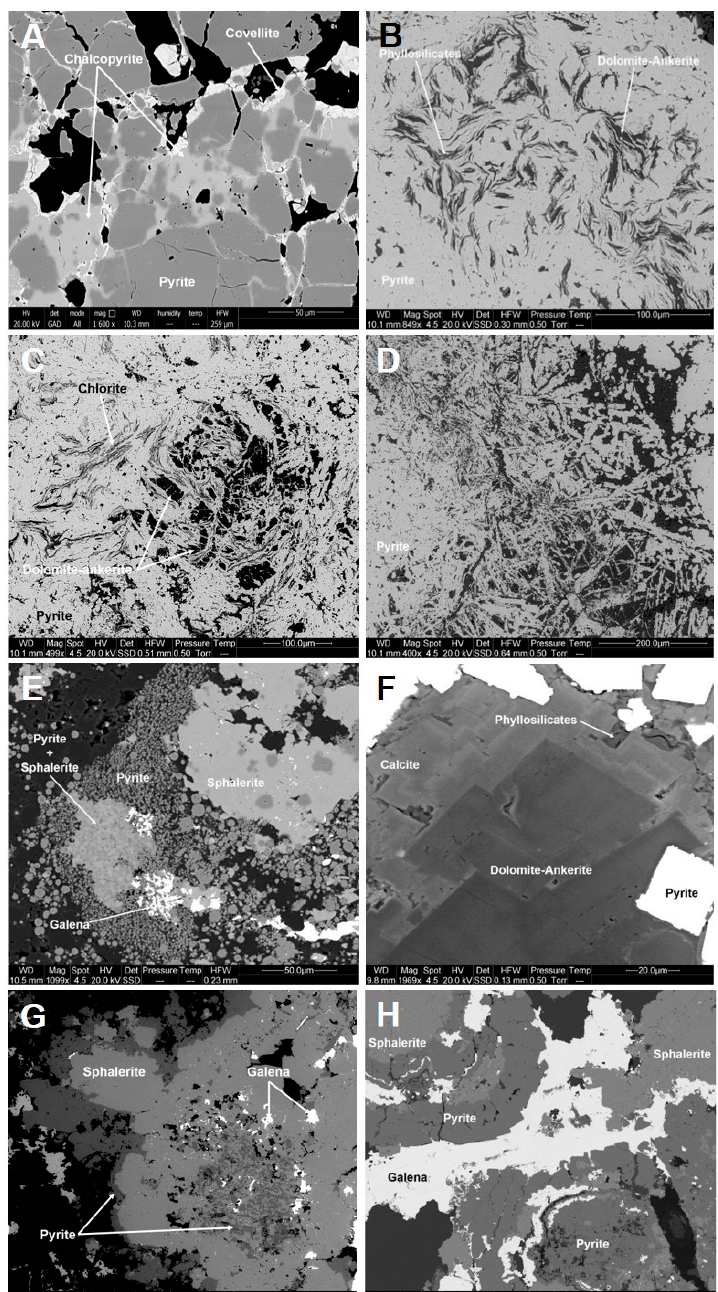
Figure 4. Back-scattered electron images of ore-related assemblages of the Castellanos orebody. ( A ) Fractured pyrite included in late massive chalcopyrite within a stockwork vein; chalcopyrite is partly replaced by covellite. ( B , C ) Massive pyrite containing flake-like crystals of phyllosilicates (mainly chlorite) and partly dissolved fragments of carbonates (dolomite-ankerite). ( D ) Lath-like crystals of pyrite interpreted as pseudomorphs of magnetite formed by pseudomorphic replace- ment of hematite. ( E ) Framboidal pyrite enclosed and partly replaced by sphalerite and, at lesser extent, galena. Galena also occurs included in sphalerite. ( F ) Zoned carbonate crystal with dolomite-dominated core and calcite rim. ( G ) Colloform aggregate of sphalerite containing galena and abundant corroded, partly dissolved crystals of a previous generation of pyrite and, in turn, enveloped by a new generation of pyrite. ( H ) Alternating colloform bands of sphalerite and pyrite with some galena which preferentially fill late spaces. Galena contains small, partially dissolved inclusions of pyrite, sphalerite and calcite.